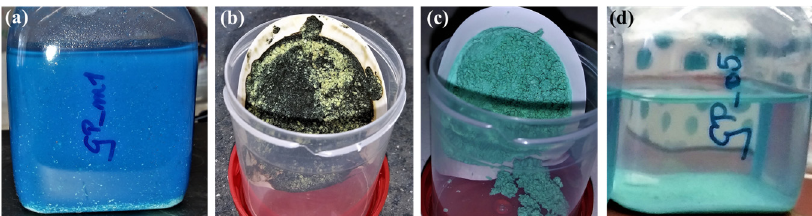
Figure 6. Photo documentation of the efficiency of Cu 2+ removal from solution by GP. ( a ) Dark blue Cu 2+ -containing solution at the beginning of experiment Cu:GP pH -1:2; ( b , c ) Precipitates obtained at the end of experiments Cu:GP-1:2 and Cu:GP pH -1:2; ( d ) Transparent solution at the end of experiment Cu:GP pH -1:2 with a Cu 2+ concentration below international guideline values.